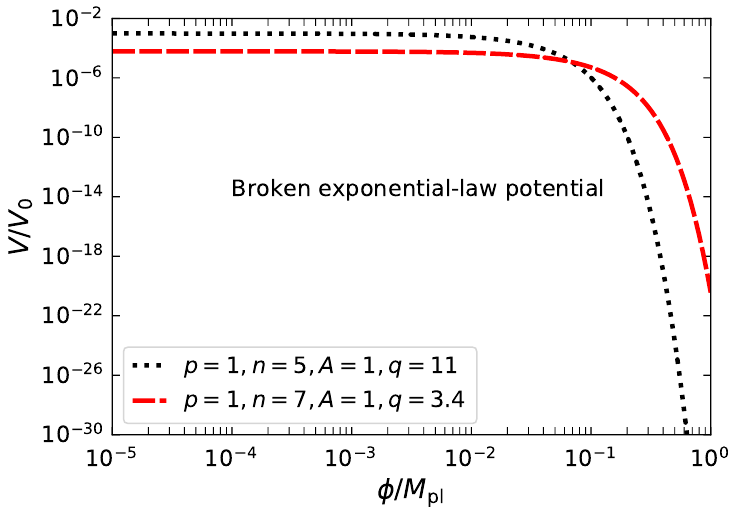
Figure 2. The figure shows the evolution of the broken exponential-law potential for two different combinations of the free parameters as a function of the scalar field φ . The black dotted line shows the potential for p = 1, n = 5, A = 1 and q = 11; the red dashed line presents a model with p = 1, n = 7, A = 1 and q =